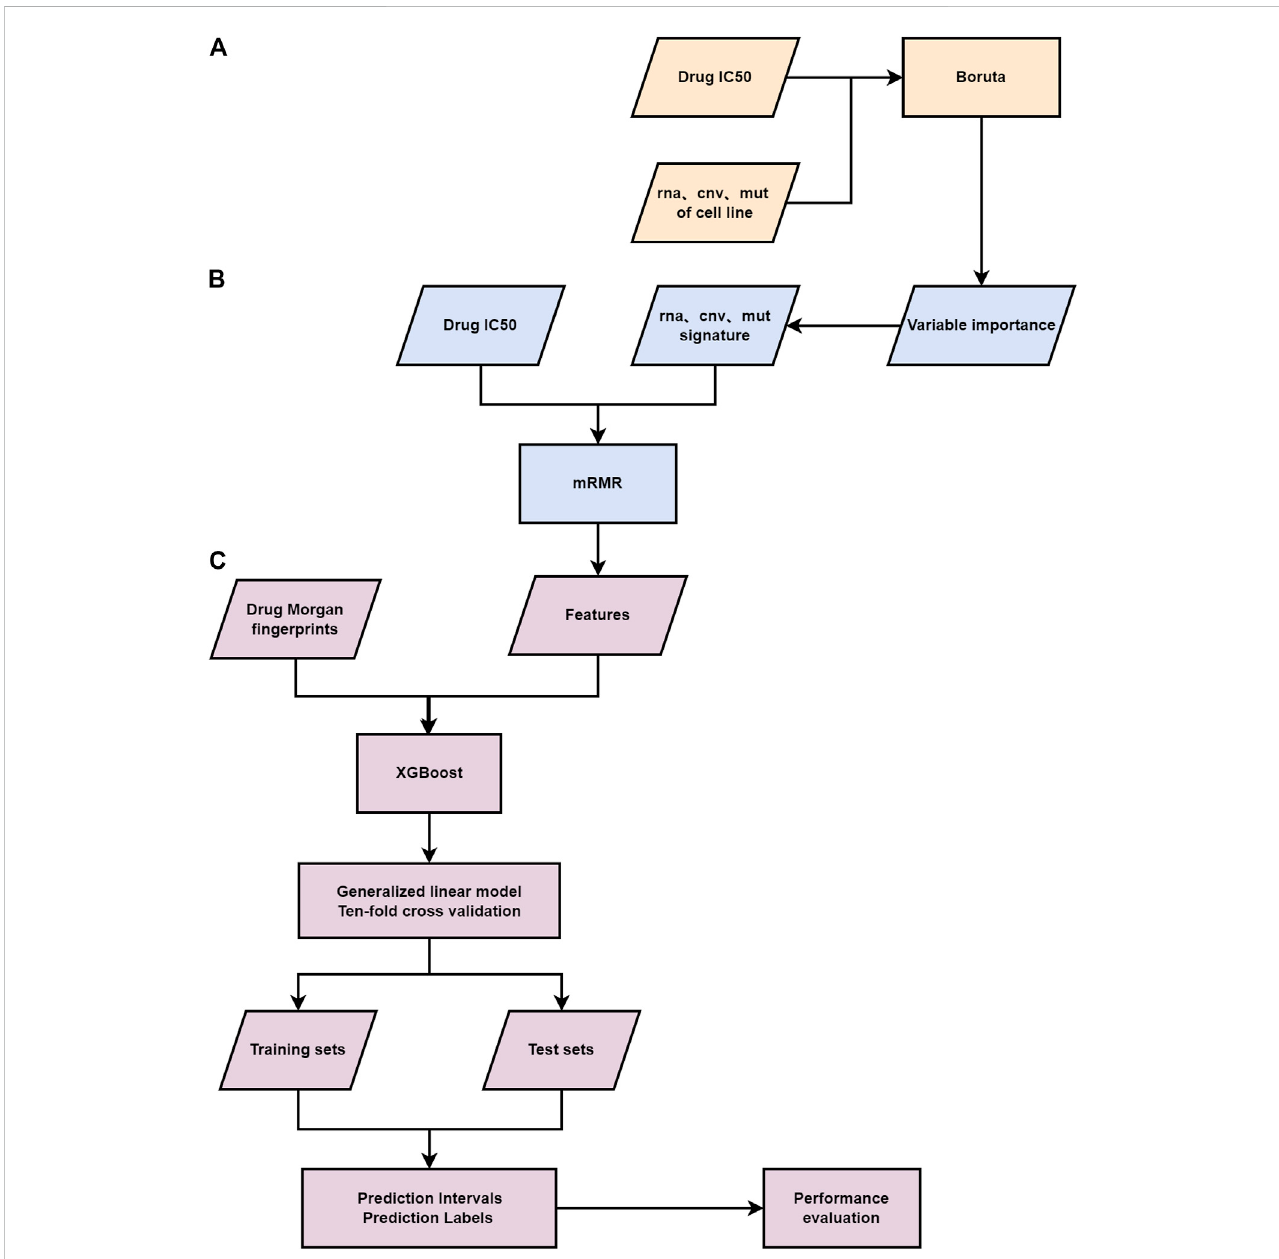
FIGURE 1 Flowchart of the study. (A) The fi rst-layer feature selection is performed on the genomic information of patients. (B) The second feature selection layer. (C) The third layer feature selection is carried out for the Morgan fi ngerprints and genomic features of drugs, a gamma distribution based GLM and ten-fold cross-validation are applied to the fi nal feature